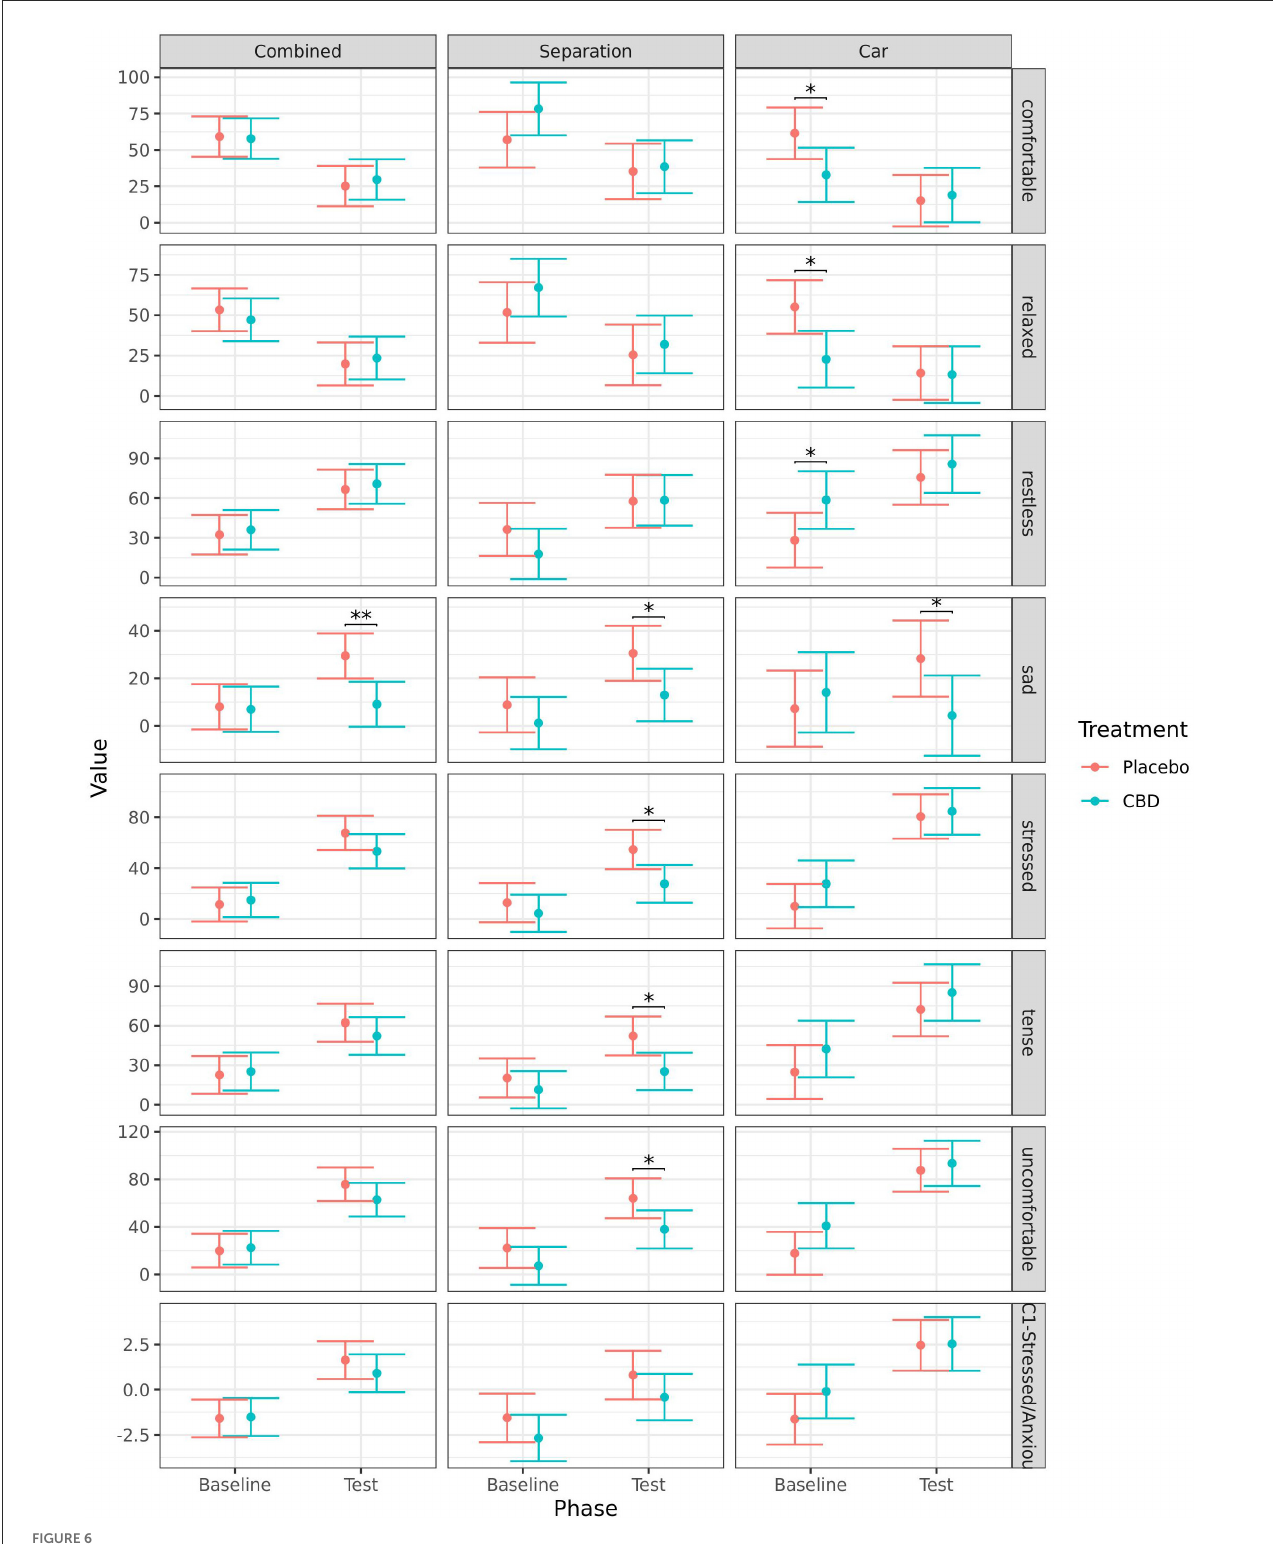
FIGURE6 Predicted mean (95% CI) QBA ratings for the terms “comfortable,” “relaxed,” “restless,” “sad,” “stressed,” “tense,” “uncomfortable,” and the component score for PC1-Stressed/Anxious for dogs given CBD or placebo at each phase of testing (baseline and test) based on models analyzing both stress tests combined, separation test or car test. Asterisks indicate significant differences between treatment groups within each phase. ** p < 0.01, and * p <